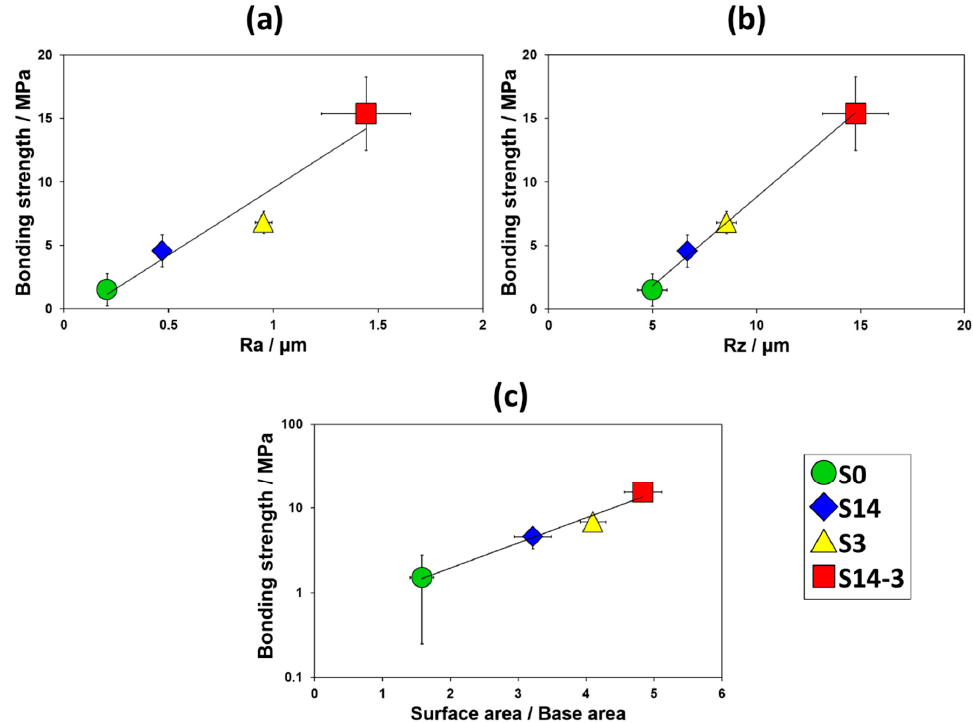
Figure 10. Changes in the bonding strength toward ( a ) R a and ( b ) R z in the surface roughness and ( c ) the value obtained by dividing the surface areas by the base areas.